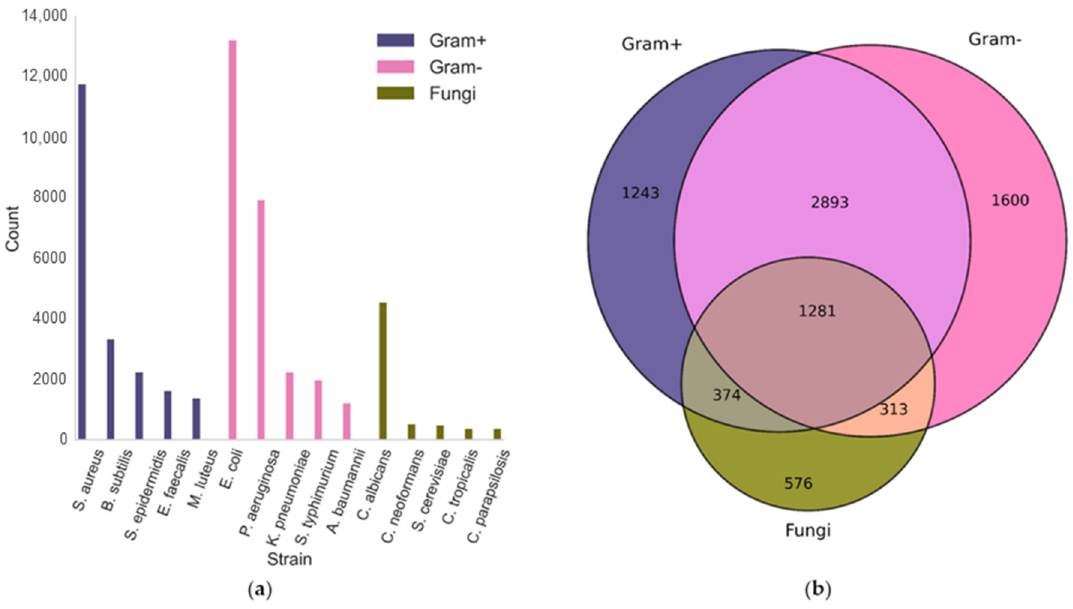
Figure 2. Number of experimental assays retrieved for the top five species by category ( a ). Venn diagram showing the distribution of peptides per category ( b ).